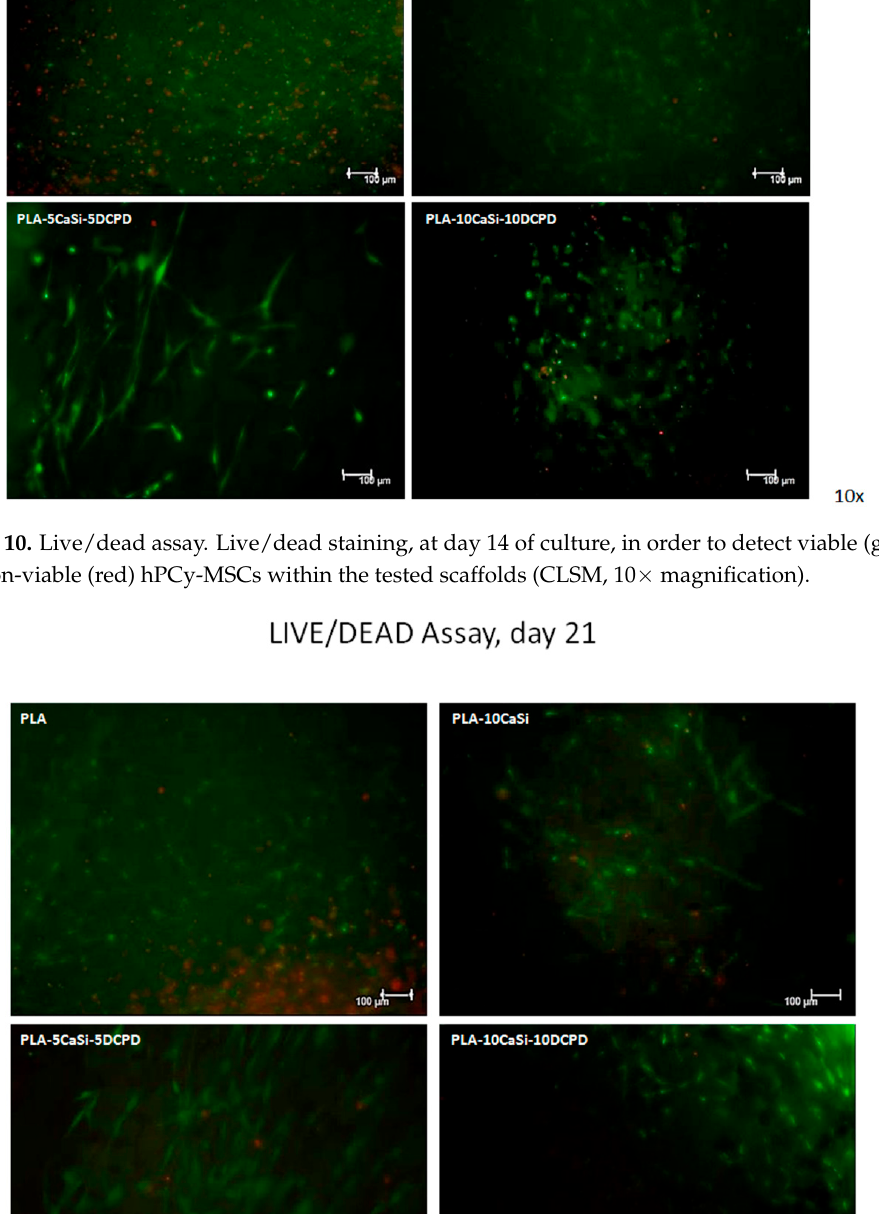
Figure 11. Live/dead assay. Live/dead staining, at day 21 of culture, in order to detect viable (green) and non-viable (red) hPCy-MSCs within the tested scaffolds (CLSM, 10× magnification).